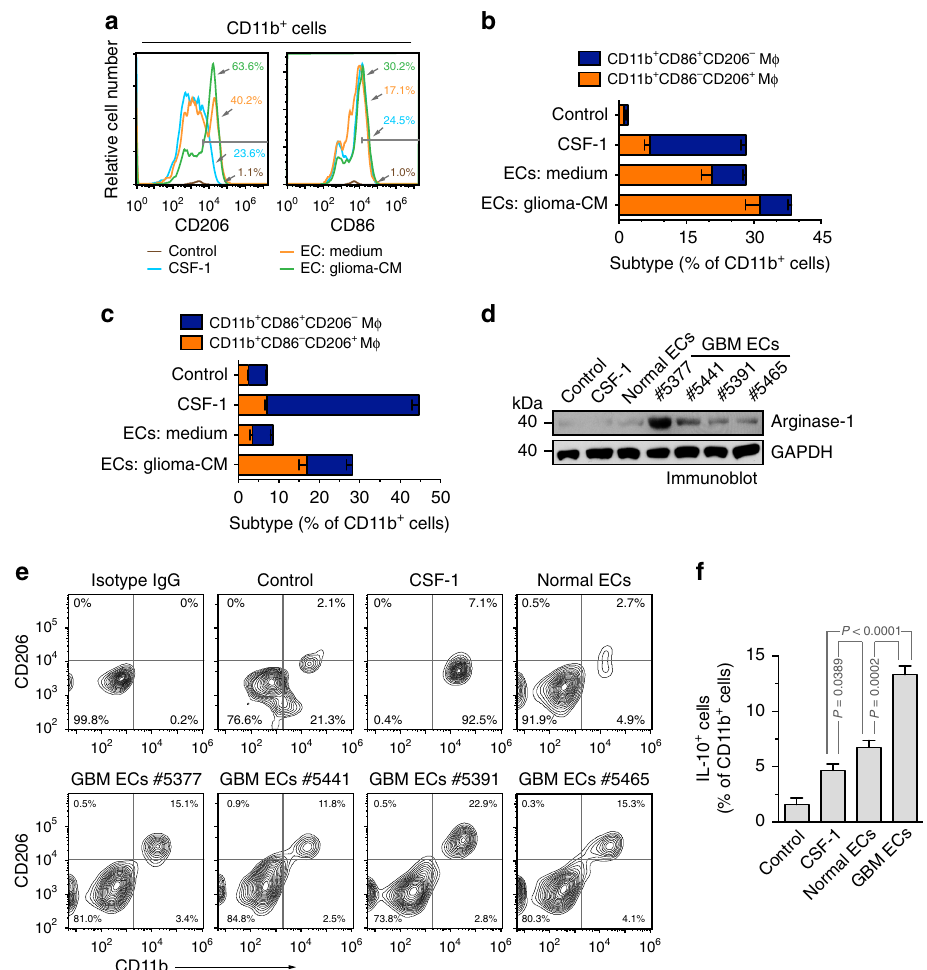
Fig. 2 GBM ECs induce alternative activation of macrophages. a , b Mouse brain microvascular ECs were pretreated with the glioma-conditioned medium (glioma-CM, harvested from medium supernatant of mouse GL26 glioma cells under 1% hypoxia) or control medium for 24 h. Mouse bone marrow (BM)- derived macrophages were incubated with CSF-1 or co-cultured with pretreated ECs for 5 days, stained with anti-CD11b, anti-CD86, anti-CD206 antibodies, and analyzed by fl ow cytometry. a Representative results of CD206 and CD86 expression in CD11b + cells. b Quanti fi ed data in sorted CD11b + macrophages (M ϕ , n = 3 – 4 mice, mean ± SEM). c Human brain microvascular ECs were pretreated with the glioma-CM (harvested from medium supernatant of human U251 glioma cells under 1% hypoxia) or control medium for 24 h. Human peripheral blood mononuclear cell (PBMC)-derived monocytes were incubated with CSF-1 or co-cultured with pretreated ECs for 5 days, stained with anti-CD11b, anti-CD86, anti-CD206 antibodies, and subjected to fl ow cytometry analysis. Quanti fi ed data in sorted CD11b + cells ( n = 3, mean ± SEM). d Human PBMC-derived monocytes were incubated for 5 days with CSF-1, or co-cultured with tumor-associated ECs isolated from different GBM patients or human normal brain microvascular ECs in upper and lower chambers of transwells, respectively. Monocytes were harvested and subjected to immunoblot analysis with anti-arginase-1 and anti-GAPDH antibodies. e Human PBMC-derived monocytes were incubated for 5 days with CSF-1, or co-cultured with tumor-associated ECs isolated from different GBM tumors ( n = 4 patients) or human normal brain microvascular ECs. Cells were harvested, stained with anti-CD206, and anti-CD86 antibodies, and subjected to fl ow cytometry analysis. Representative images are shown. f PBMC-derived monocytes were incubated for 5 days with CSF-1, or co-cultured with tumor-associated ECs isolated from GBM patient #5377 or human normal brain microvascular ECs. Cells were harvested, stained with anti-IL-10 and anti-CD11b antibodies, and subjected to fl ow cytometry analysis ( n = 5, mean ± SEM). P values were determined by Student ’ s t